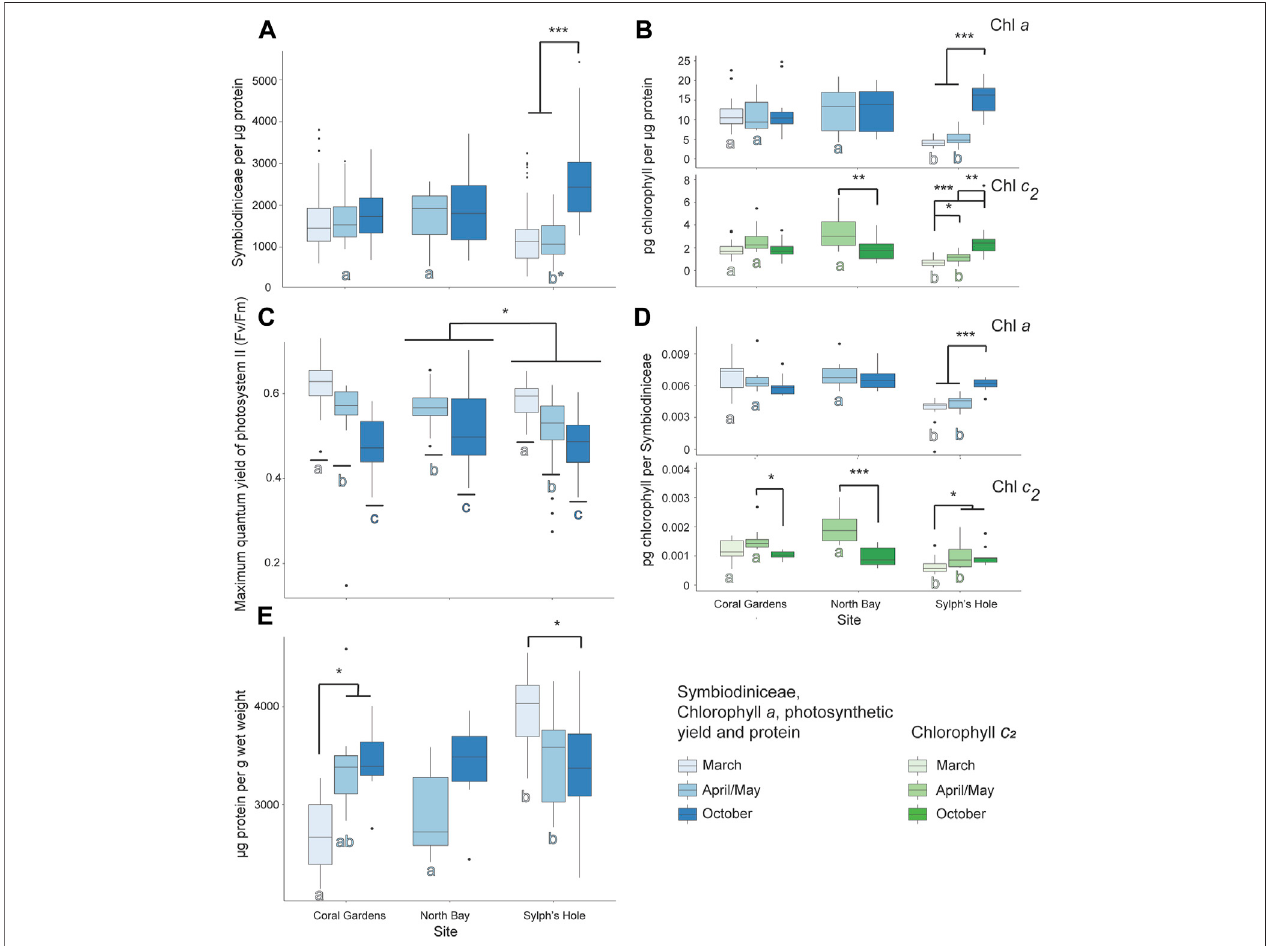
FIGURE6| Marineheatwaveeffectsonunbleached Cladiella sp.1acrossthreereefsintheLordHoweIslandlagoon. (A) Symbiodiniaceaedensityperµgproteinin unbleached Cladiella sp.1colonies duringMarch, April/May, and October. (B) Chlorophyll a (above)and c 2 (below) densities per µgproteininunbleached Cladiella sp.1 coloniesduringMarch,April/May, andOctober. (C) PSIIphotochemistryinvisuallyhealthy Cladiella sp.1coloniesduringMarch,April/May, andOctober. (D) Chlorophyll a (above)and c 2 (below)perSymbiodiniaceaecellinvisuallyhealthy Cladiella sp.1coloniesduringMarch,April/May,andOctober. (E) µgproteinpergwetweightin visually healthy Cladiella sp. 1 colonies during March, April/May, and October. Signi fi cance is designated either by different letter group or by a bar. p -values are representedasfollows — *for p < 0.05,**for p < 0.005,and***for p < 0.0005.Wheremorethanoneplotisgroupedtogether,thehighest p -valueisreported.Barsabove the boxplots represent monitoring interval differences within site, and letters below the boxplots represent site differences within monitoring intervals.